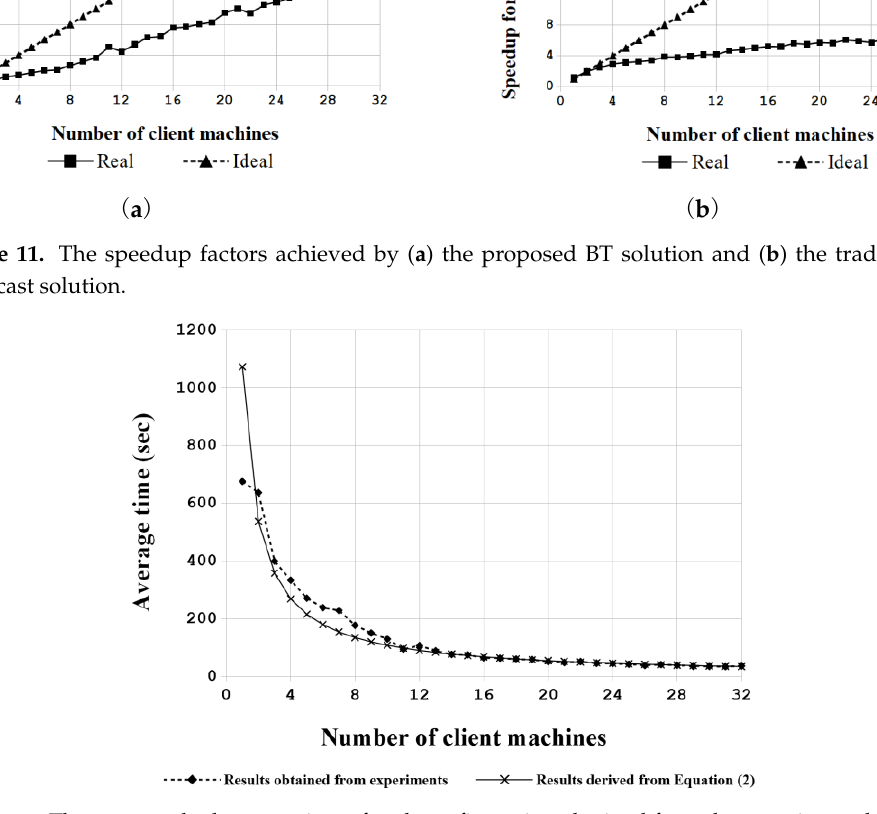
Figure 12. The average deployment time of each configuration obtained from the experimental results based on the proposed BT solution as well as the ideal deployment time derived from Equation (2).